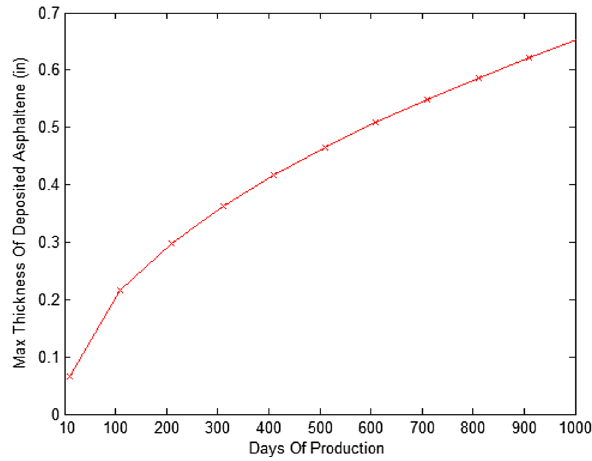
Fig. 14 Thickness of deposited asphaltene on tubing surface in depth of 12,000 ft